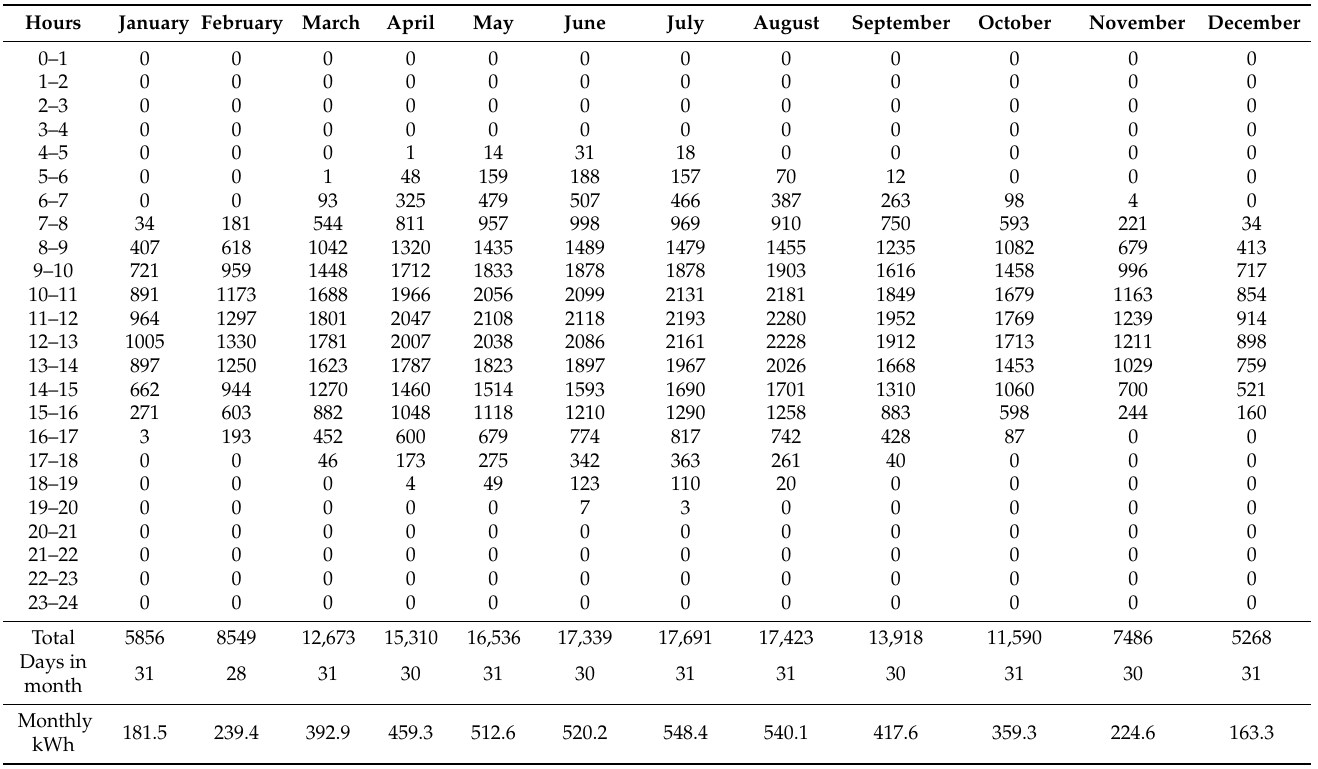
Table 5. Average daily electricity production (Wh)